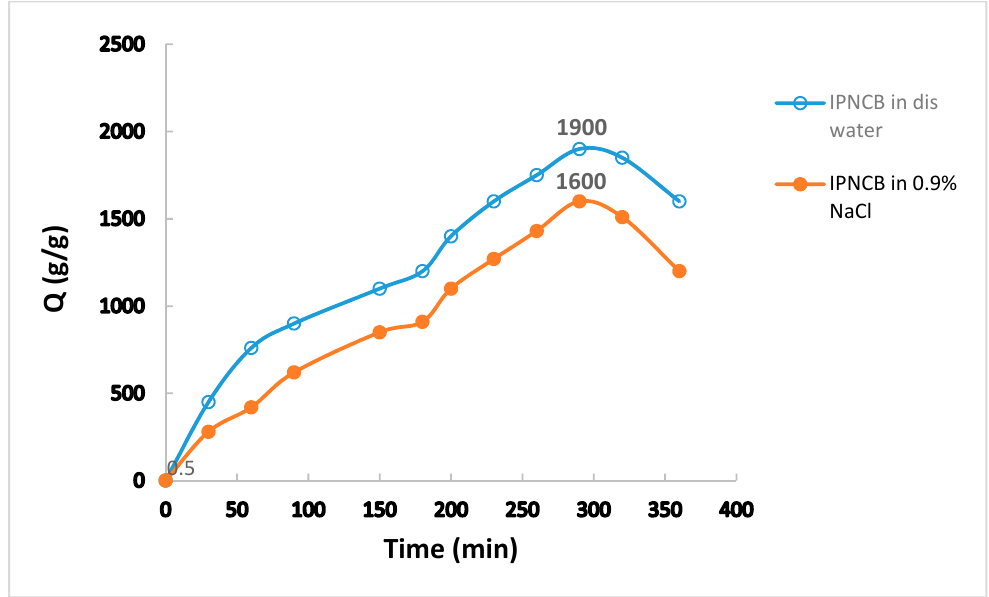
Figure 7. Swelling behavior of the IPNCB composite in different media.